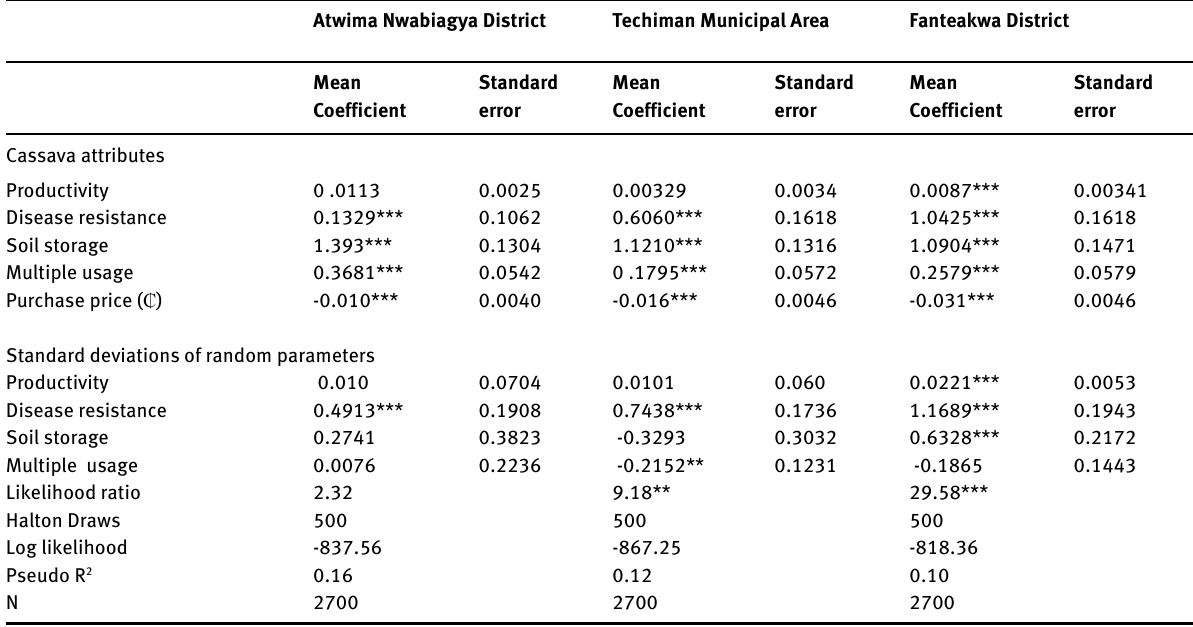
Table 5: Simulated maximum likelihood estimates of preferences for cassava traits for